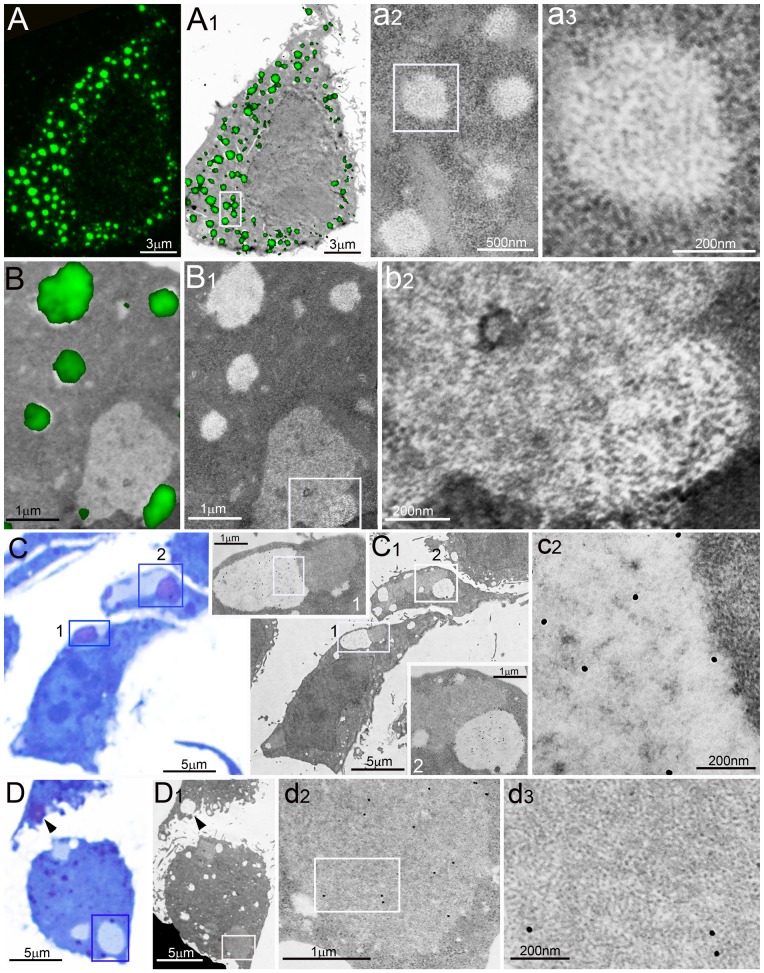
Correlative light/electron microscopy of PaCSs.(A, B) Direct correlation between confocal microscopy immunofluorescence and TEM in an aldehyde–osmium fixed HeLa cell. (A) 20S proteasome immunofluorescence (green) of numerous cytoplasmic bodies, projected on the corresponding TEM micrograph (A1) to show overlapping of proteasome immunofluorescence spots with cytoplasmic PaCSs; a few of which are enlarged in (a2) and further in (a3) to show their distinctive ultrastructure. (B) Combined immunofluorescence/TEM image showing several proteasome-reactive PaCSs (green) and a large proteasome-unreactive sequestosome, as shown by TEM alone in (B1); part of the sequestosome and an adhering PaCS are enlarged (b2) to show their distinctive ultrastructure. (C and D) Direct identification of metachromatic bodies with PaCSs using consecutive semithin (light microscopy)/thin (TEM) section analysis from aldehyde–osmium-fixed, resin-embedded HeLa cells. Toluidine blue staining of a semithin section shows red–violet metachromatic bodies (C), corresponding to clear areas in a consecutive TEM section (C1). Boxed areas are enlarged in insets 1 (further enlarged in c2) and 2 to magnify 20S proteasome immunogold, besides faintly contrasted PaCS-type particles. Note the weak grey–blue staining (C) and the heavier electron density (C1) of the two sequestosomes adhering to boxed PaCSs and showing granular–fibrillary ultrastructure (c2) (right upper corner). (D and D1) Several small PaCSs in the bottom cell and a larger one in the upper cell (arrowhead) heavily stained by toluidine blue (D), while three sequestosomes were lightly stained. Most of such bodies were also identified by TEM in a consecutive thin section (D1), where PaCSs appeared as clear spots and sequestosomes as areas with intermediate electron density. The largest sequestosome is enlarged in (d2) and (d3) to magnify its thin granular–fibrillary ultrastructure and p62 protein immunoreactivity.